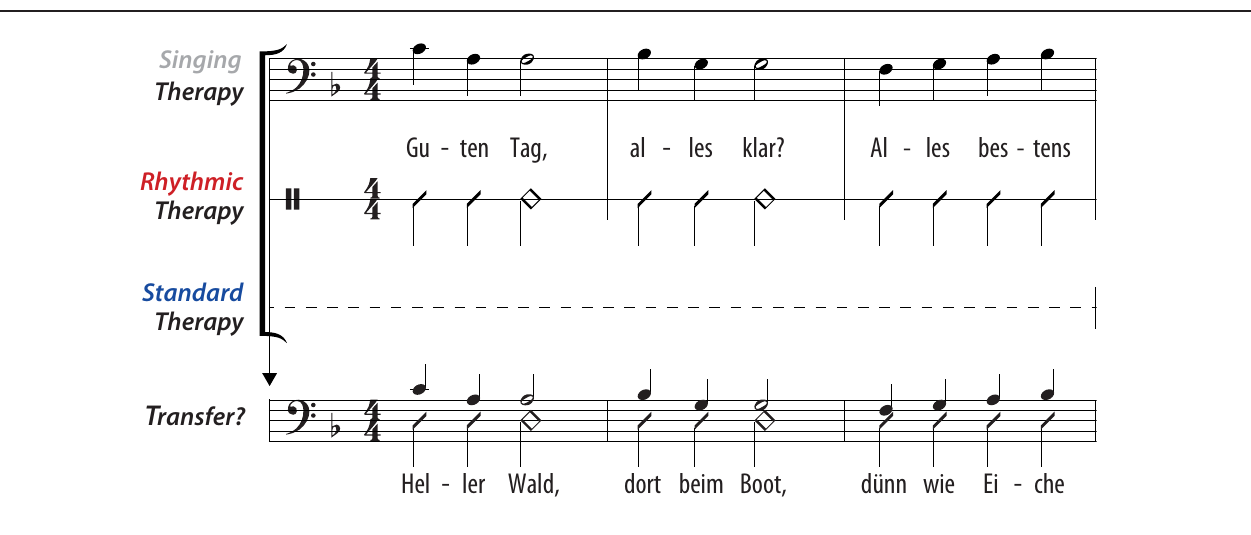
FIGURE 1 | Schematic overview of the experimental design. Three types of treatment were applied: singing therapy, rhythmic therapy, or standard therapy. In singing therapy , patients underwent training of common, formulaic lyrics by singing them to a well-known melody (“Hello, everything alright? Everything’s fine ... ”). In rhythmic therapy , patients were trained using the same lyrics, but rhythmically spoken with natural prosody. In